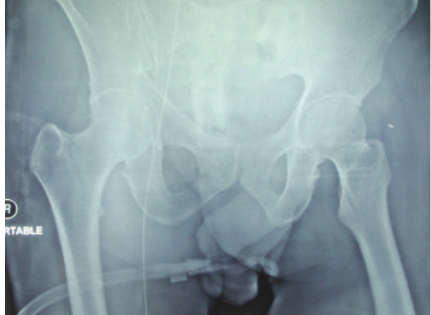
Figure 1: Chest X-ray showing an endotracheal tube, an orogastric tube, a left-sided subclavian central venous catheter, a left-sided chest tube, and multiple superficial leads. There is additional shadow (arrow heads) that could not be accounted for.